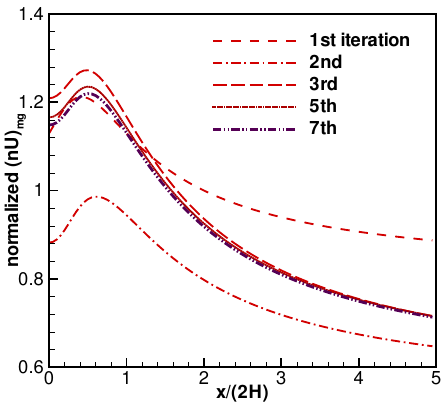
√ 2 RT 0 ) profile development